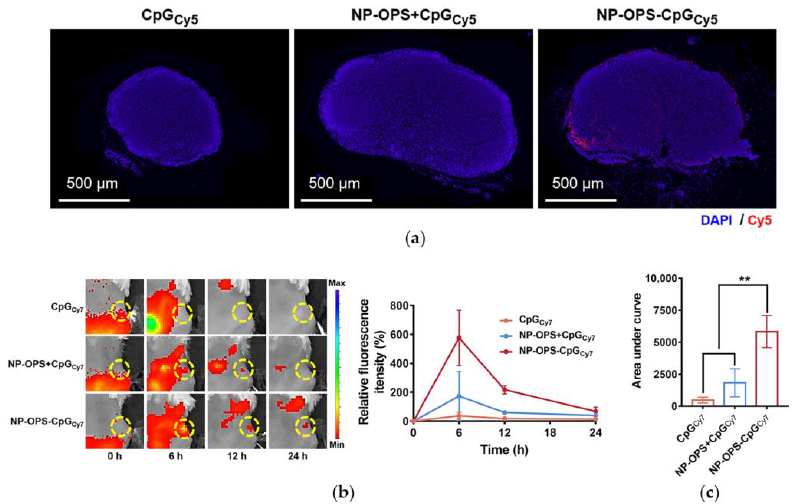
Figure 3. Lymph node targeting of the bioconjugate nanovaccine. ( a ) NP-OPS-CpG Cy5 was injected into the tail base of mice with CpG Cy5 and NP-OPS+CpG Cy5 as controls. Lymph nodes were obtained from 6 h post-injection mice. Cryosections of dLNs were stained with DAPI (DAPI: blue; Cy5: red) (n = 3). ( b ) Representative images and corresponding quantitative fluorescence analyses of different vaccines (CpG labeled with Cy7) in dLNs (n = 3). The dLNs site was circled as shown. ( c ) Accumulation of CpG (labeled by Cy7) in lymph nodes within 24 h (n = 3). Data are presented as means ± SD. Each group was compared with NP-OPS-CpG Cy7 using one-way ANOVA: ** p < 0.01. 3.4. Analysis of CpG Phagocytosis by DC2.4s